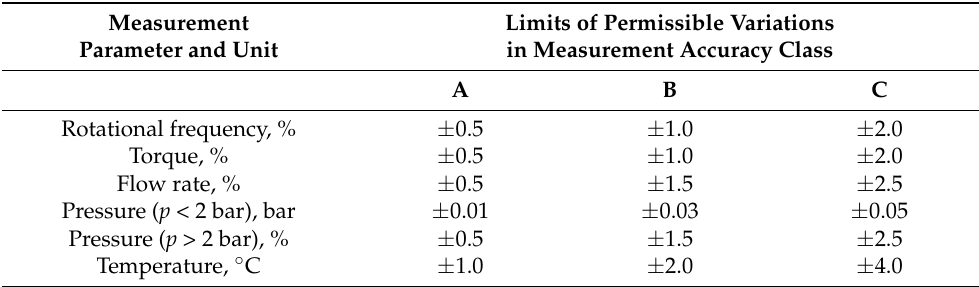
Table 1. Maximum permissible variations in the values of measurement parameters in each measure- ment accuracy class when measuring steady state performance of pumps